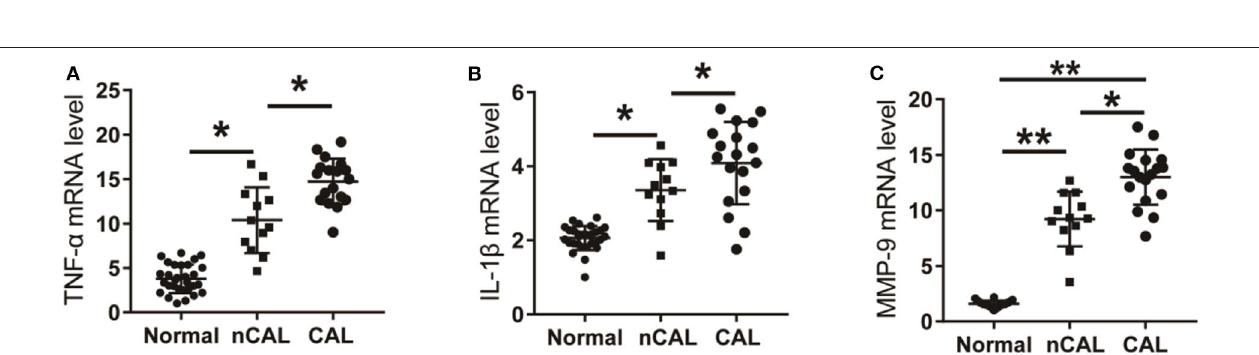
FIGURE 5 | The levels of inflammatory factors in KD patients with CAL or nCAL. (A) TNF- α level in patients with KD. (B) IL-1 β level in patients with KD. (C) MMP-9 level in patients with KD. * P < 0.05; ** P < 0.01.